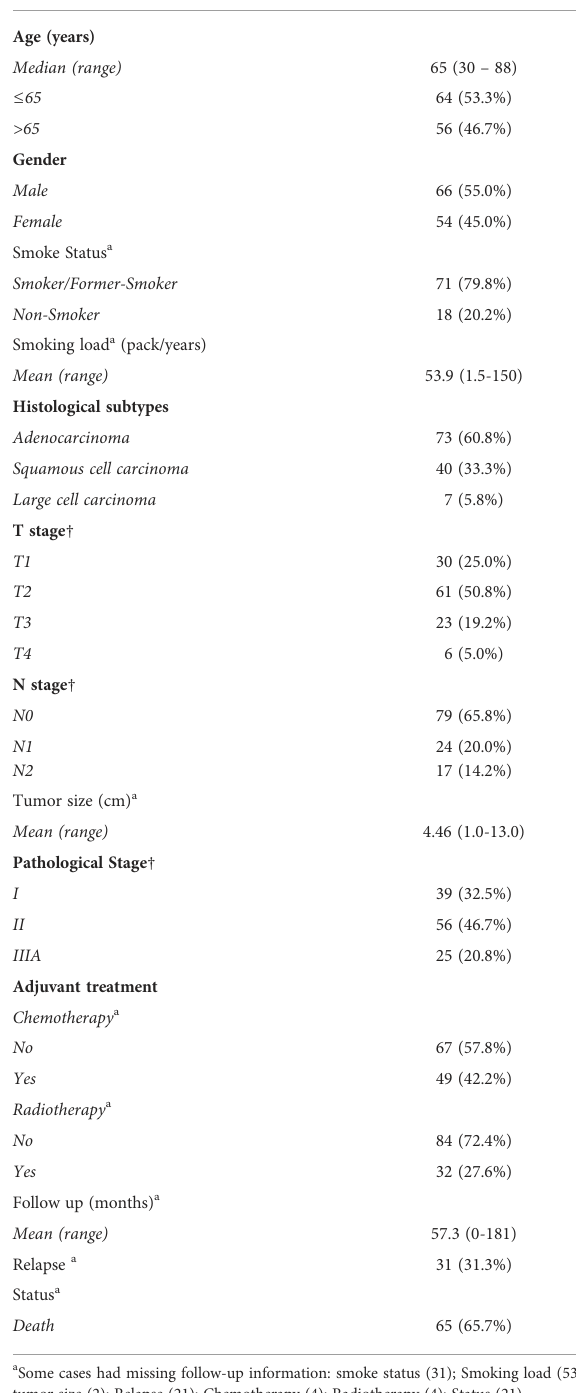
TABLE 1 Demographic and clinicopathologic characteristics of the patients